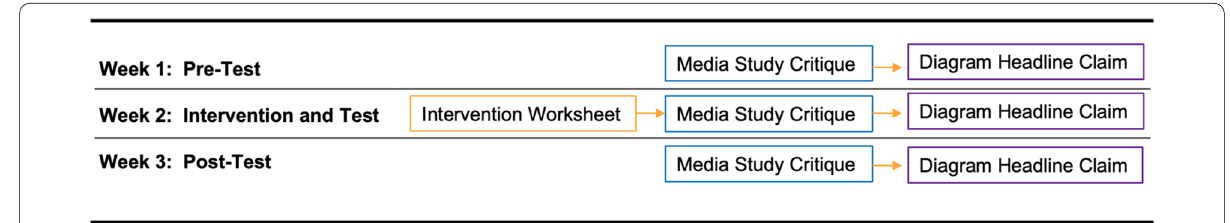
Fig. 1 Graphical depiction of questionnaire content for each session in the longitudinal